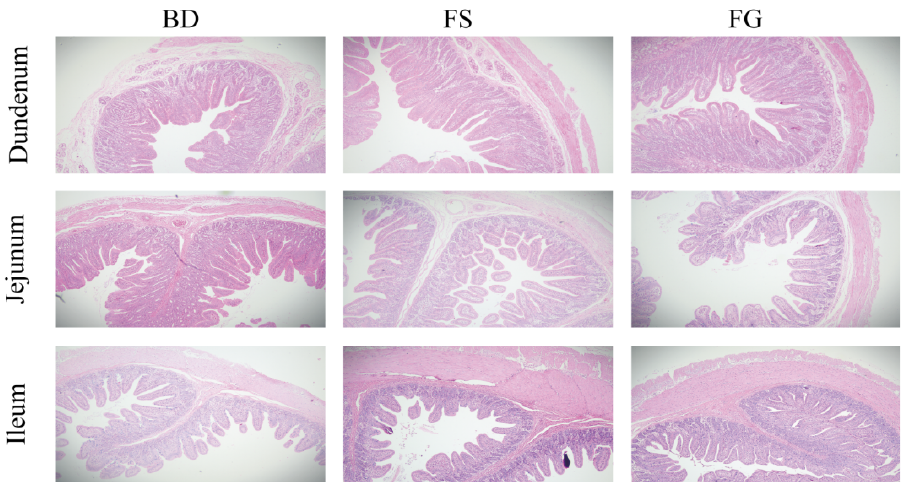
Figure 1. Effect of SPCI on intestinal morphology in weaned pigs (H&E; × 40). BD, basal diet with no iron supplementation; FS, basal diet with FeSO 4 (containing 100 mg Fe/kg) supplementation; FG, basal diet with Fe ‐ Gly (containing 100 mg Fe/kg) supplementation.